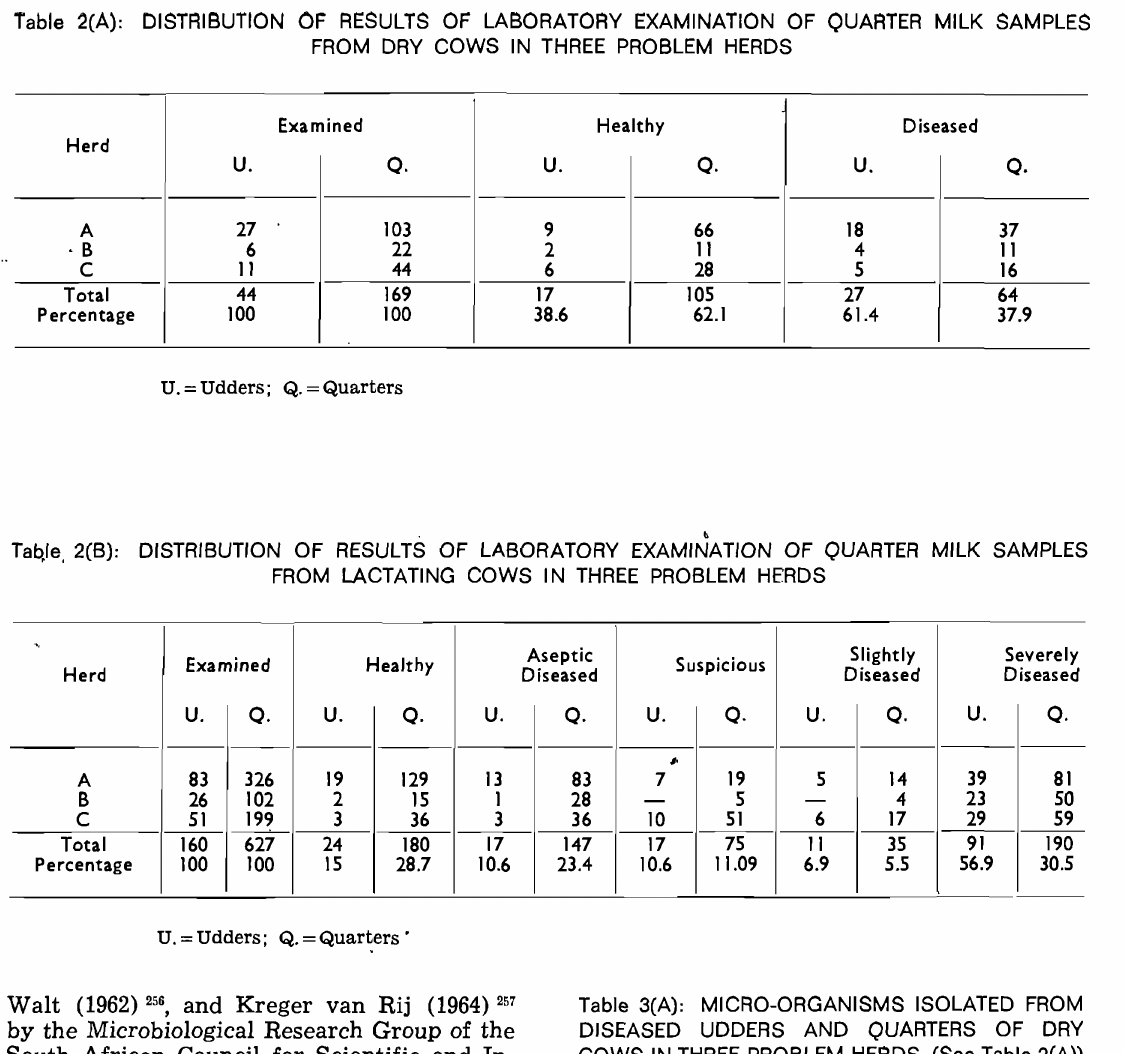
Table 3(A): MICRO-ORGANISMS ISOLATED FROM DISEASED UDDERS AND QUARTERS OF DRY COWS IN THREE PROBLEM HERDS. (See Table